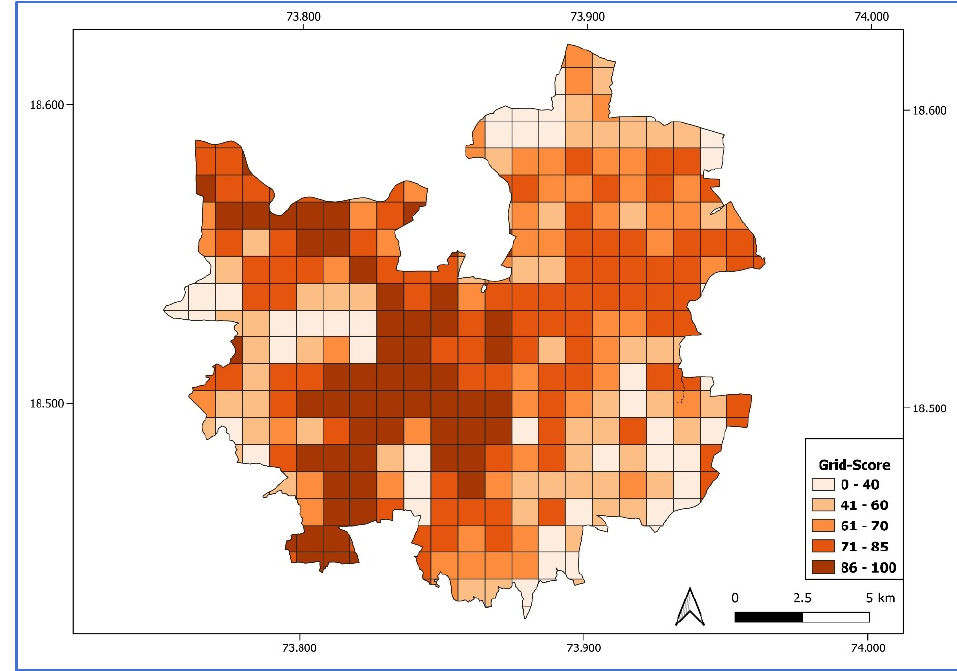
Figure 5. City divided into grids ranked from 0 to 100.